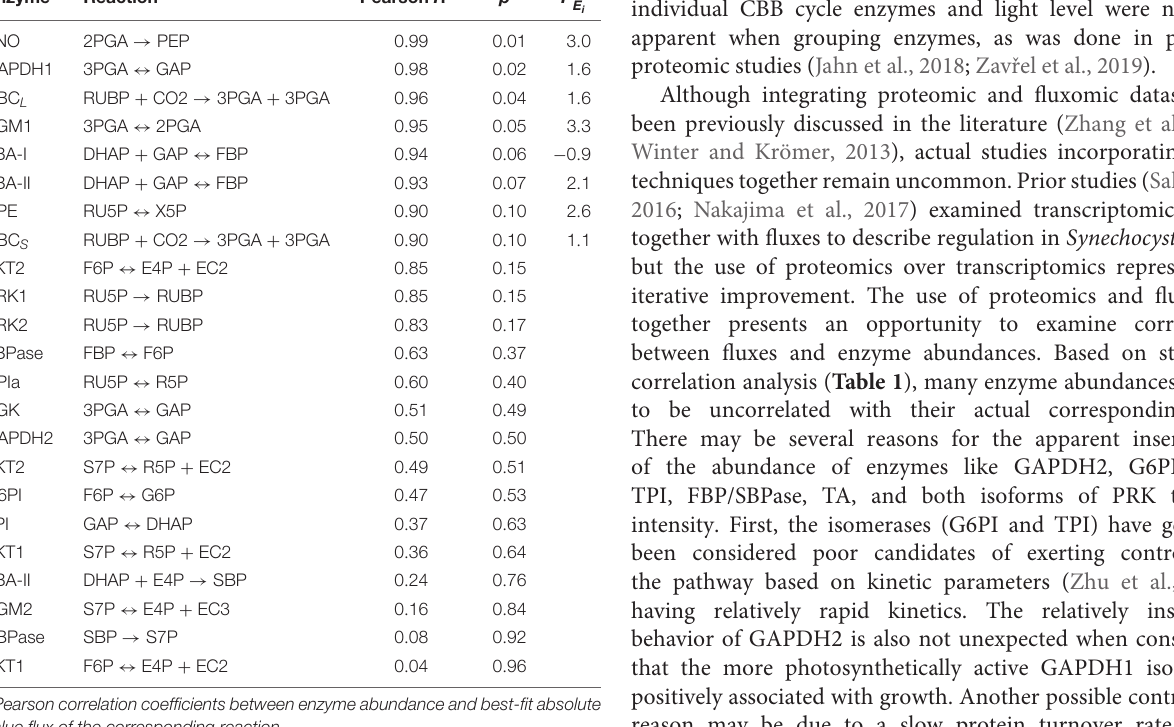
TABLE 1 | Calculated Pearson R 2 and Pseudo-Flux Control Coefficients. Enzyme